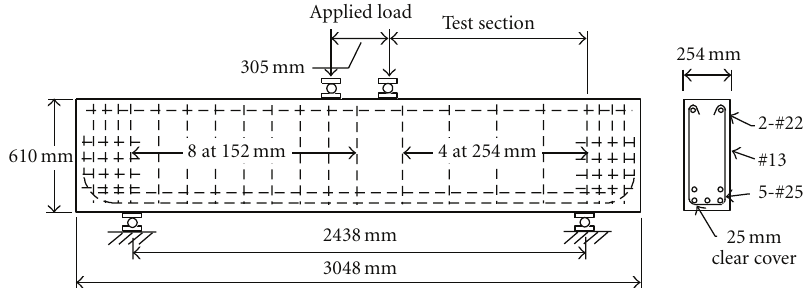
Figure 1: Experimental specimen configuration.